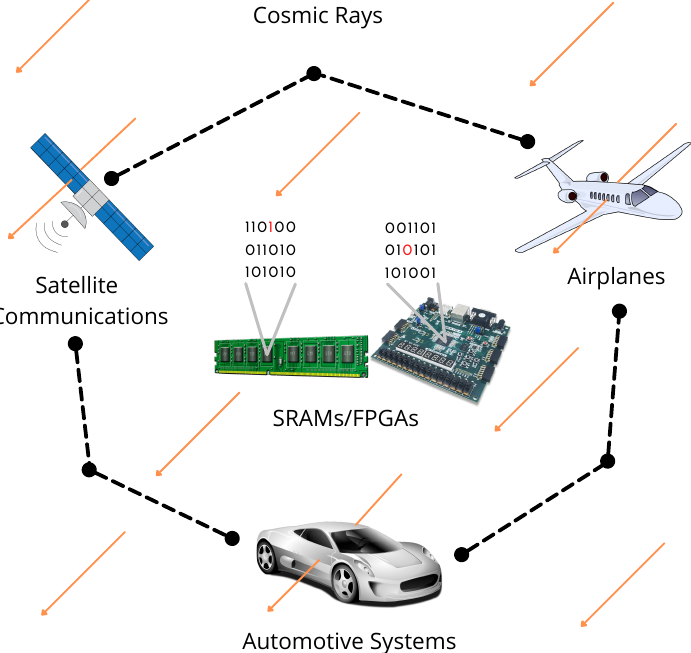
Figure 1. Automotive system affected by cosmic